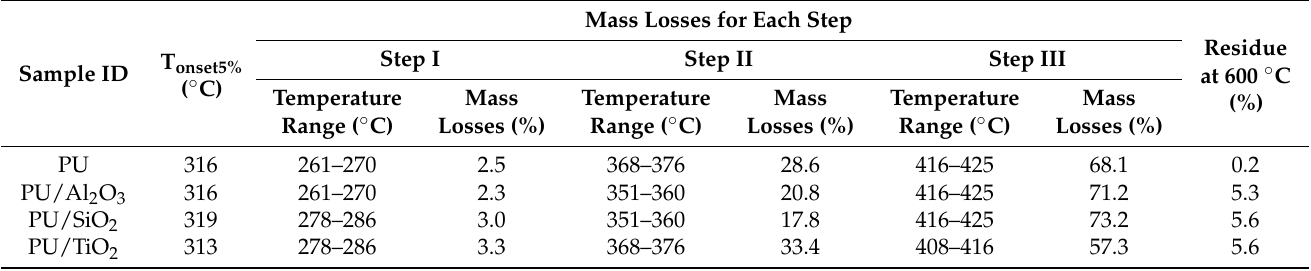
Table 2. Thermogravimetric data of different PU/ceramic composites.